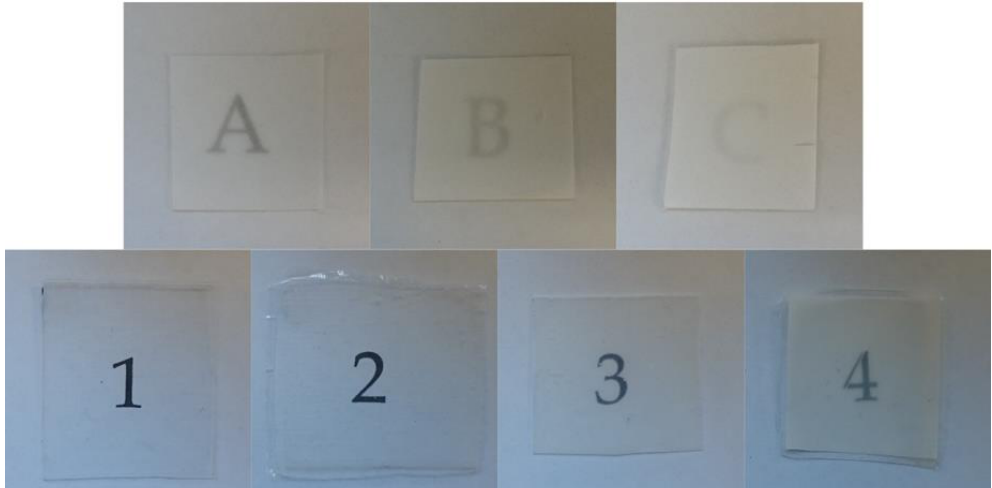
Figure 3. Visual appearance and contact transparency of the gallic acid (GA)-containing polylactide (PLA) films of: ( A ) bilayer 1 h; ( B ) bilayer 2 h; ( C ) bilayer 3 h; ( 1 ) monolayer; ( 2 ) multilayer 1 h; ( 3 ) multilayer 2 h; and ( 4 ) multilayer 3 h.